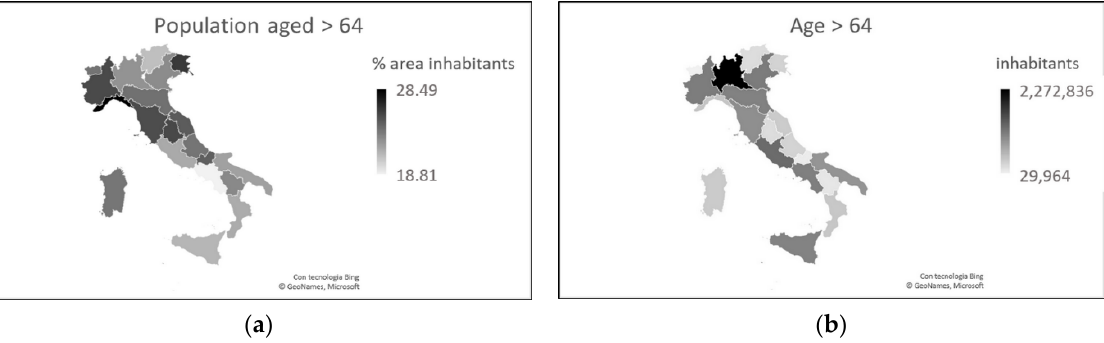
Figure 3. Distribution of the Italian population aged > 64 in percentage ( a ) and absolute ( b ) terms (updated to 2019).